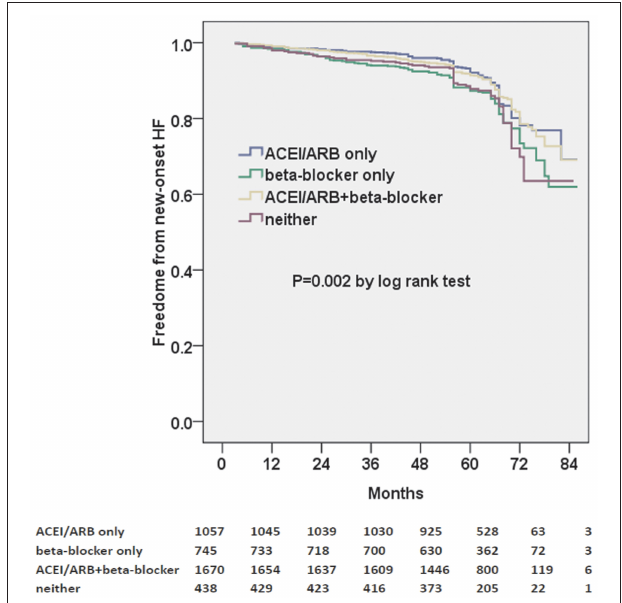
FIGURE 2 | Kaplan–Meier curves of freedom from new-onset HF for different medical treatments. The numbers at the bottom of the figure are “number at